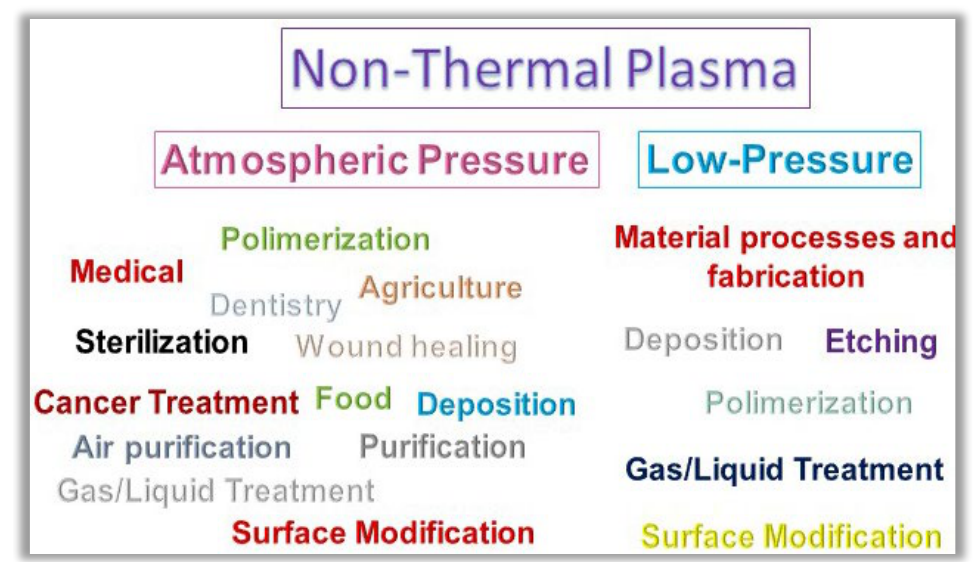
Figure 2. Fundamental applications of the non-thermal plasma at atmospheric and low-pressure.